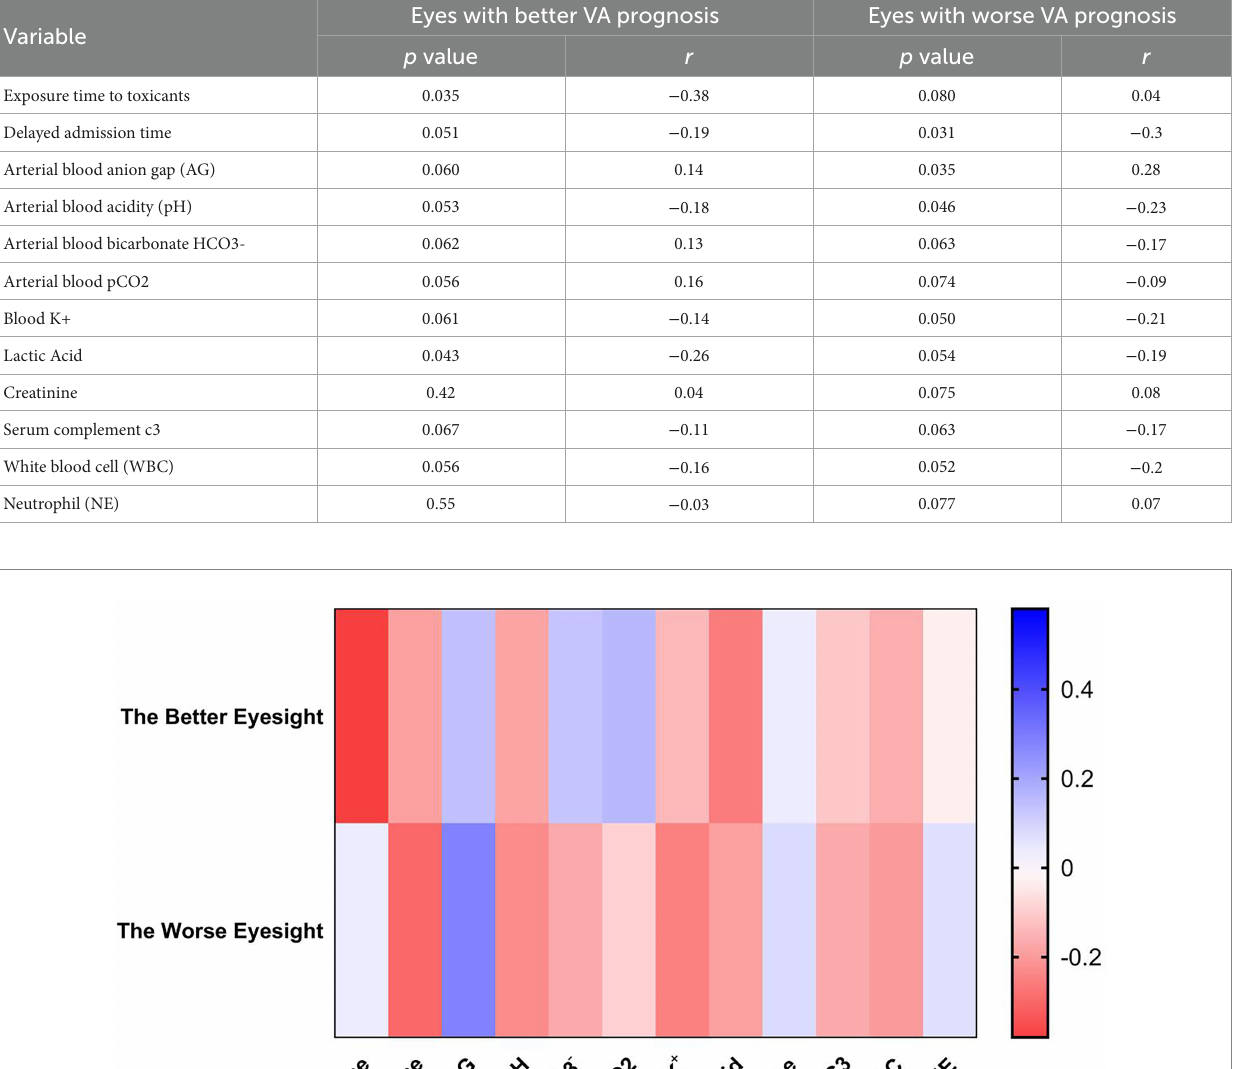
Eyes with better VA